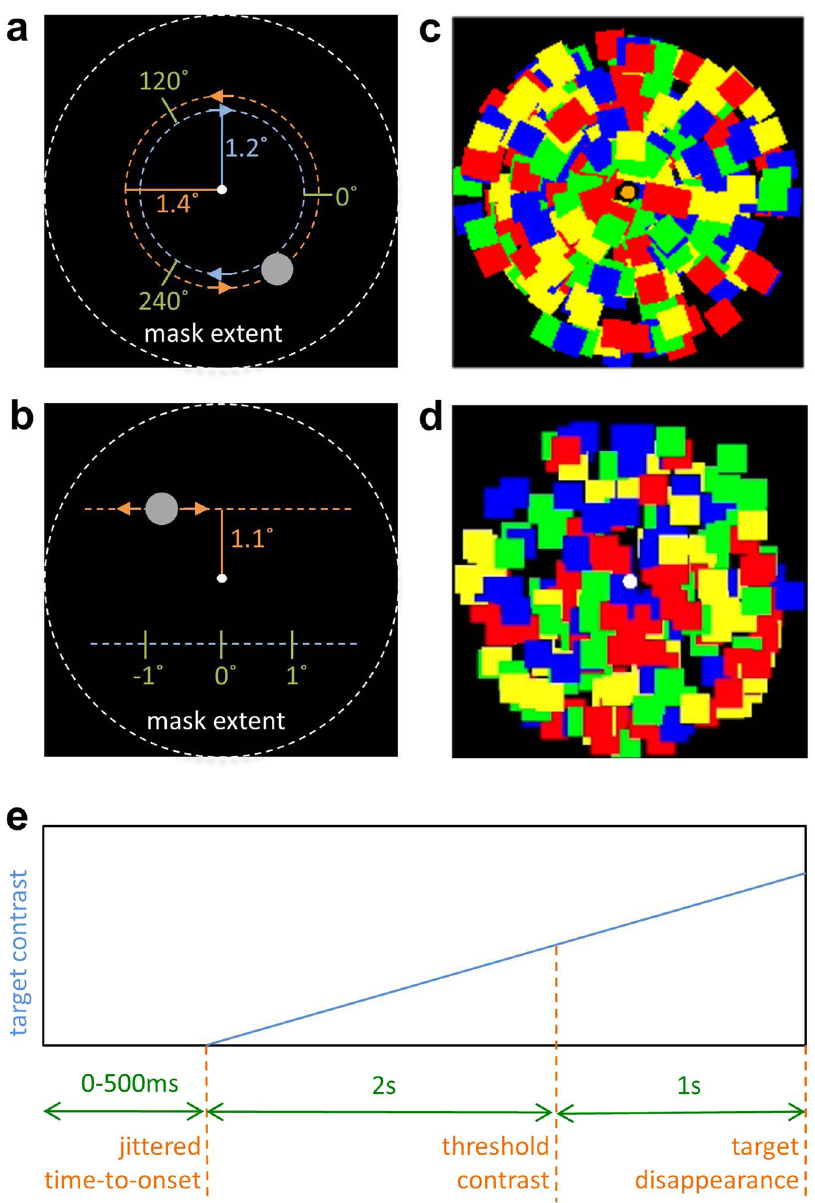
Figure 1. Target and mask configurations and target contrast ramp-up. ( a , b ) Target configuration. Target in grey ; green : starting positions; orange and blue : movement direction, possible trajectories and their distances from the center; white : the extent of the mask. ( a) Rotational target. ( b) Linear target.( c ) Rotational mask. ( d) Linear mask. ( e ) A schematic of change in target contrast throughout the trial. The target begins to accrue in contrast after a jittered onset (0–500ms) and reaches the contrast threshold (variable during threshold measurement and fixed during the main experiment) at 2 s. The participant’s task is to press a button as soon as the target is detected. The target always disappeared 3 s after the onset, even if the button was already pressed, to discourage speeded responses. If the threshold value was greater than 1 (i.e., the target was too difficult to detect even with a ramp up to maximum value within 2 s), the contrast was ramped up to maximum (1) at 2 s and remained there for the rest of the trial, while the mask contrast was reduced by (2 – threshold) and did not vary in a given